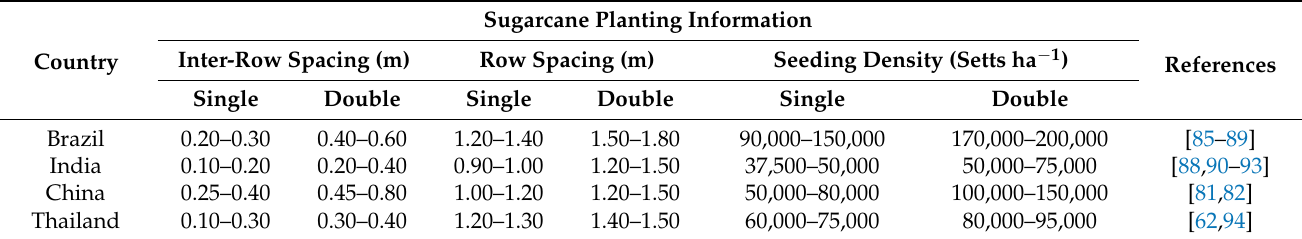
Table 1. Sugarcane planting information on producing